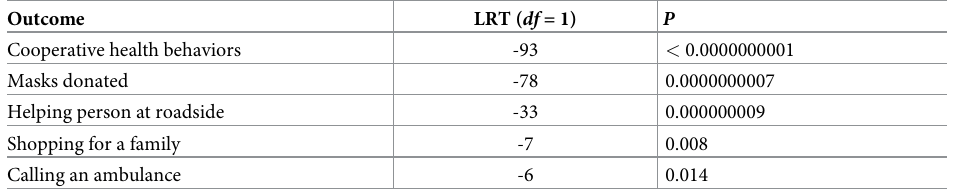
Table 2. Likelihood ratio tests (LRT) showing that identification with all humanity (Model 2) significantly improves model fit over control variables (Model 1) for each of the five